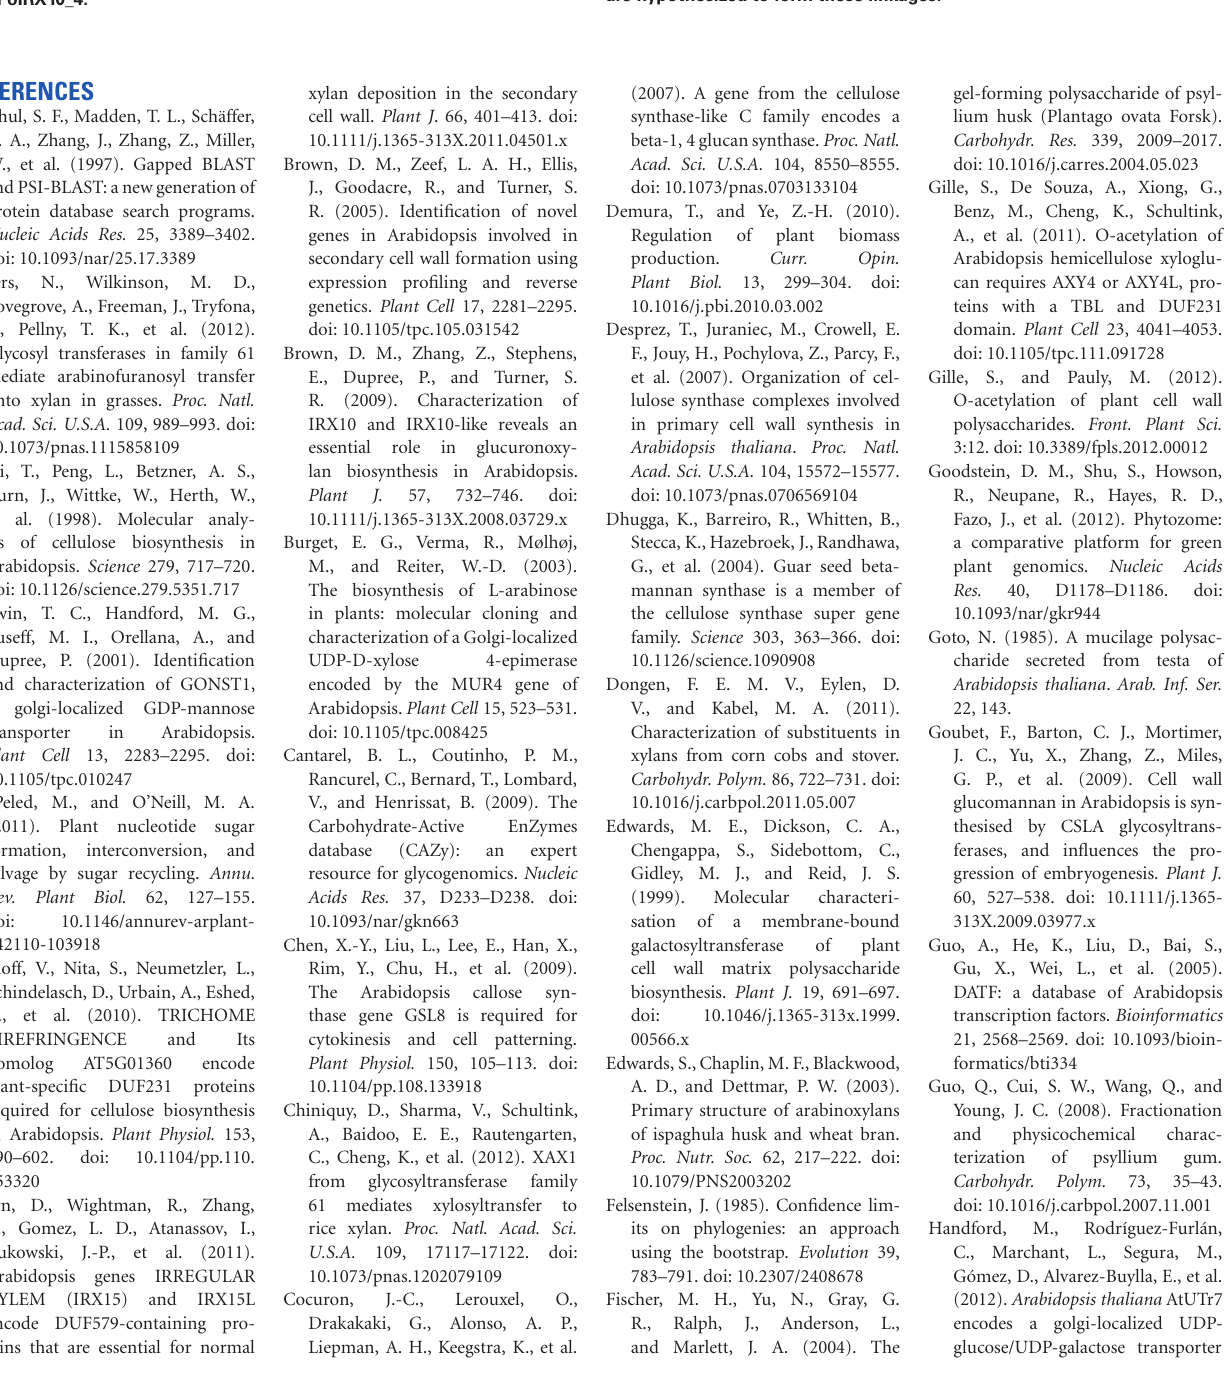
File S2 | Protein sequence alignment of IRX10 proteins. File S3 | SALAD dendrogram and motif alignment of IRX10 proteins. File S4 | Protein sequence alignment of GT61 proteins. Table S1 | 454 FLX sequencing and assembly of sequence reads. Table S2 | Pairwise amino acid maximum identity scores using BLAST. Table S3 | Glycosyl linkages identified in psyllium mucilaginous heteroxylan and putative glycosyltransferases identified in this study that are hypothesized to form these